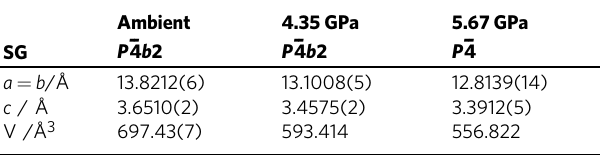
Table 1 Experimentally determined lattice parameters for (1) before and after the phase